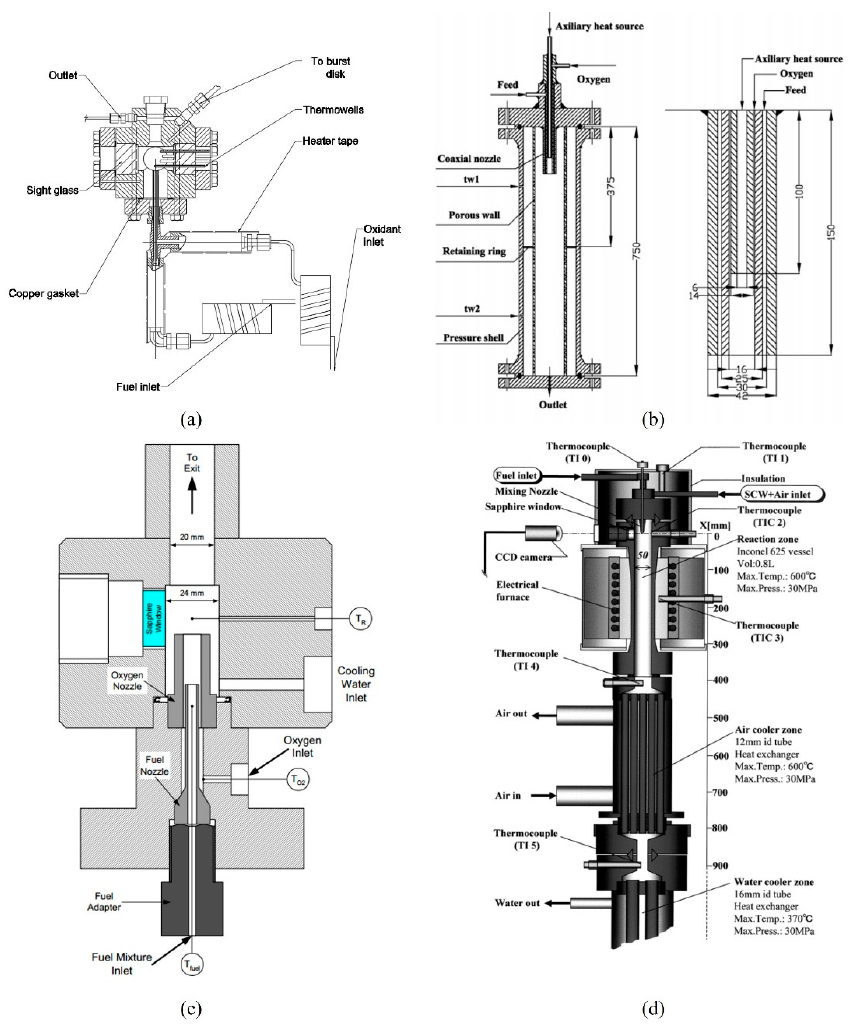
Figure 6. ( a ) NASA John H. Glenn Research Center (adapted from [58]); ( b ) Shandong University (adapted from [56]); ( c ) MIT (adapted from [52]); ( d ) Ebara Research Company (adapted from